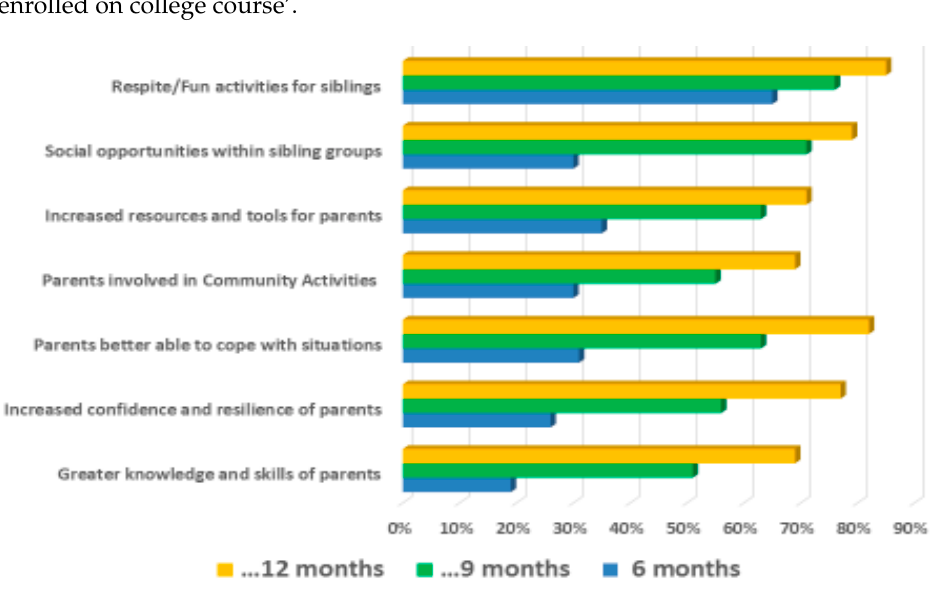
Figure 2. The percentage of parental targets rated as ‘fully achieved’ at the three reviews.